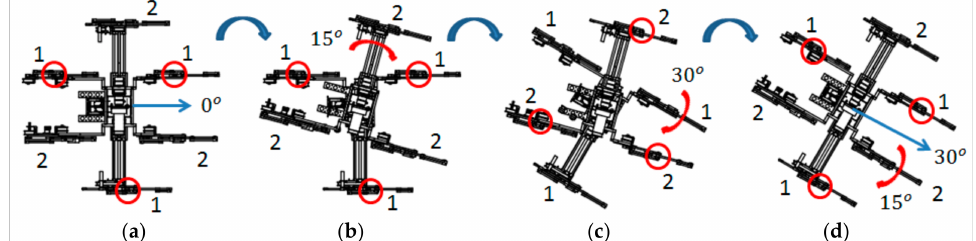
Figure 13. The robot changes its azimuth through a series of motions where the legs of the bottom deck and the upper deck are labeled as 1 and 2, respectively, while the red circles stand for the legs standing statically on the ground. ( a ) Initial posture. ( b ) The upper deck suspends its legs and makes a swing 15 ◦ clockwise, while the legs of the bottom deck stay on the ground. ( c ) The bottom deck suspends its legs and makes a swing 30 ◦ clockwise, while the legs of the upper deck stay on the ground. ( d ) The upper deck suspends its legs and makes a swing 15 ◦ clockwise, while the legs of the bottom deck stand on the ground.